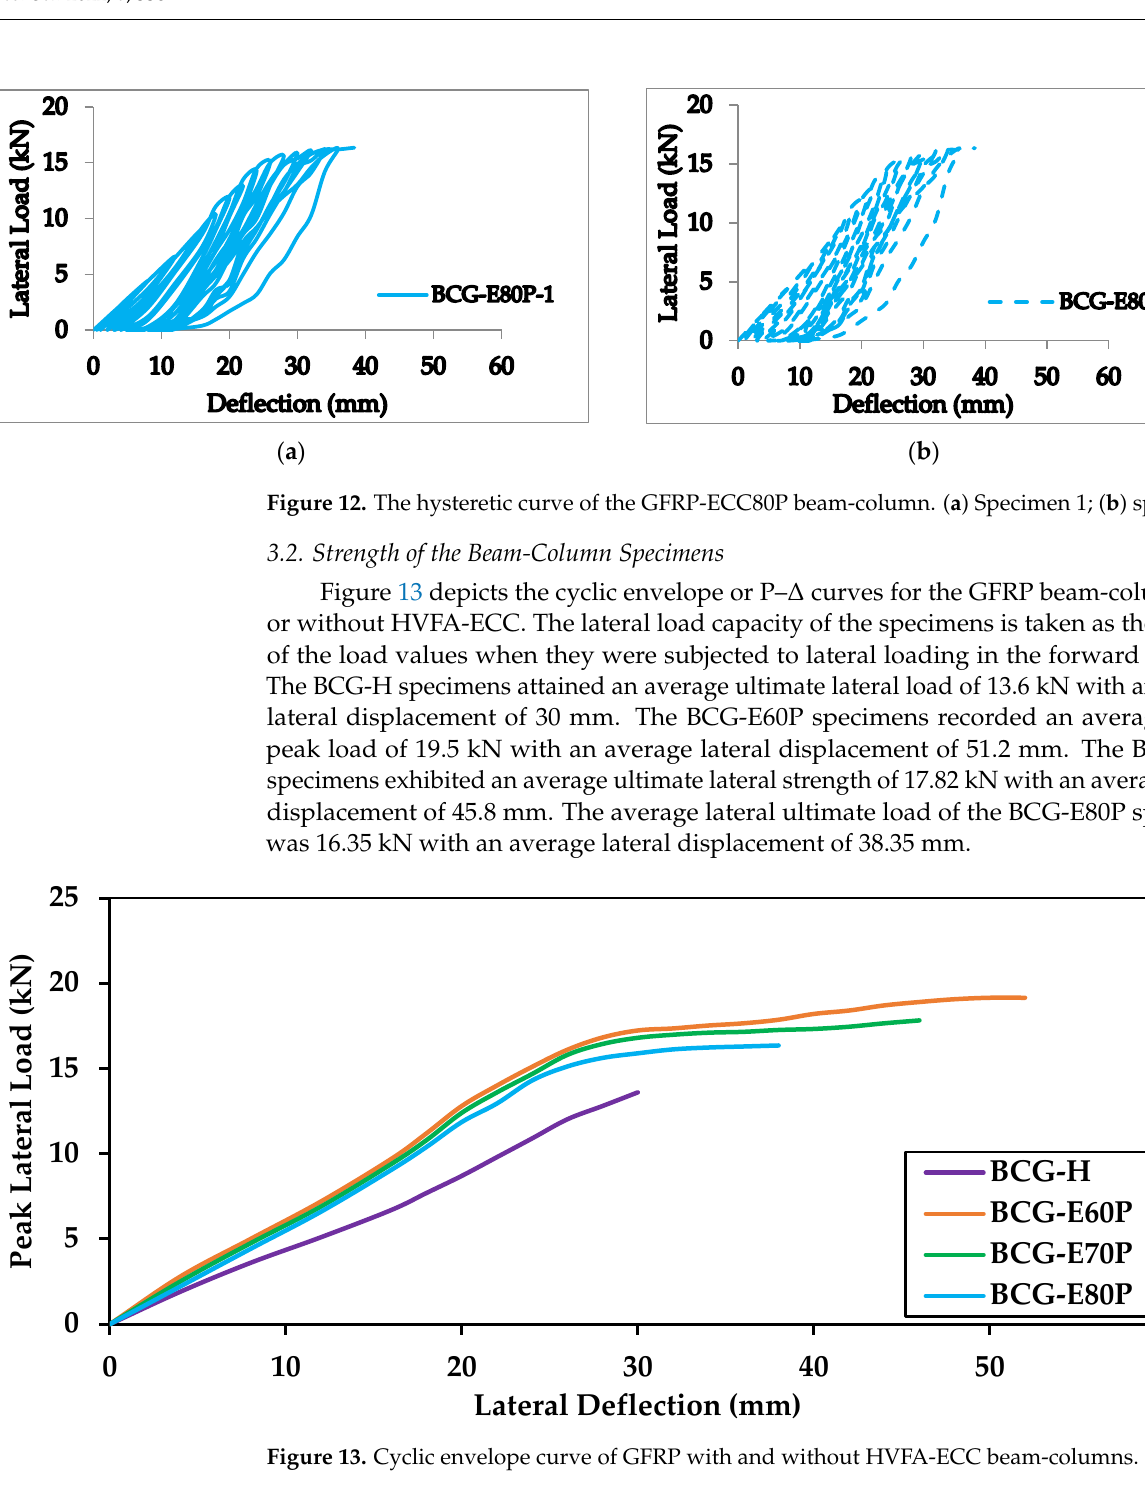
Figure 11. The hysteretic curve of the GFRP-ECC70P beam-column. ( a ) Specimen 1; ( b ) specimen